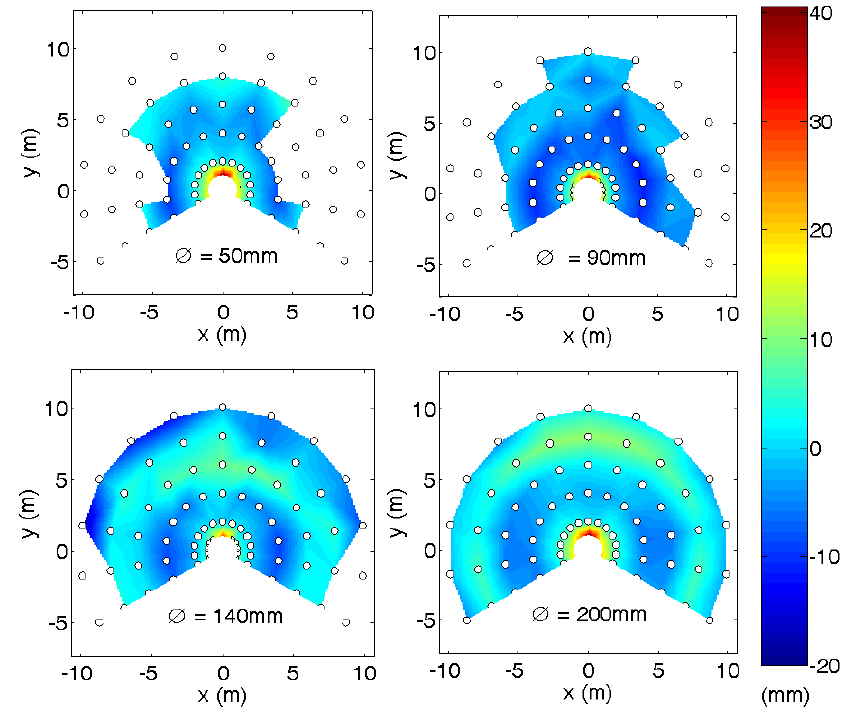
Figure 13. Average distance error map expressed in mm relative to the target.